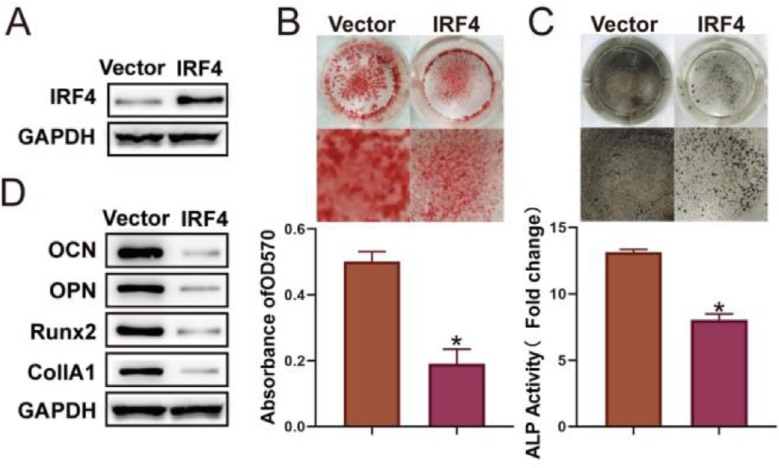
Fig. 2. Osteogenic differentiation of BM-MSCs is inhibited by IRF4 overexpression. BM-MSCs with IRF4 overexpression were constructed, and Western blotting was used to examine the transfection ef fi cacy (A). ARS (B) and ALP (C) staining assays were performed for the assessment of osteogenic differentia- tion. Western blotting was used to detect osteogenic differenti- ation biomarkers (D). * p < 0.05. Data represent at least three independent sets of